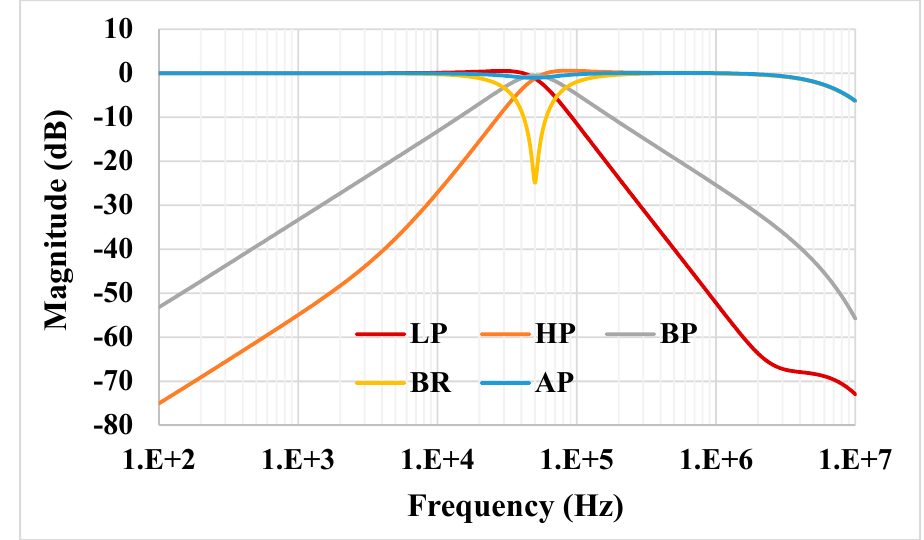
Figure 9. Frequency characteristics of the proposed universal filter.